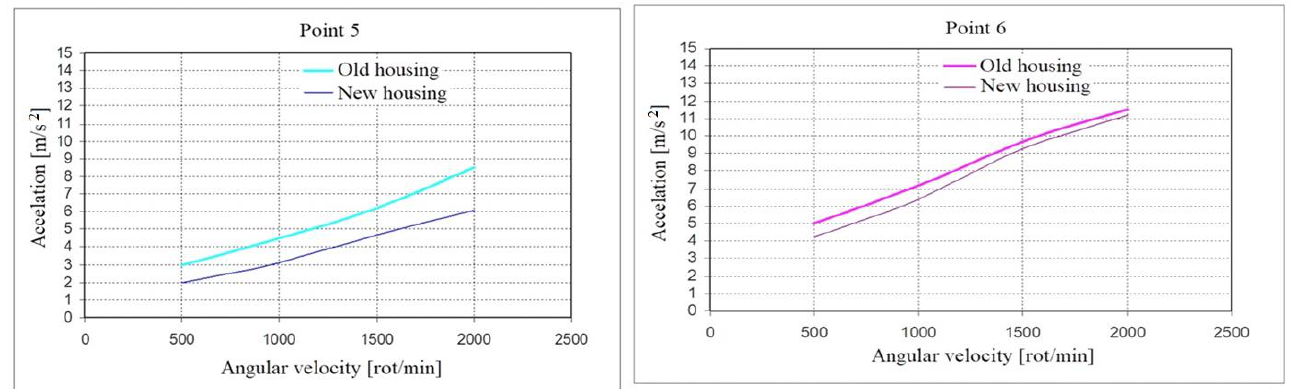
Figure 24. The velocities determined at points 1 and 2 of the two adder boxes (old and new version).